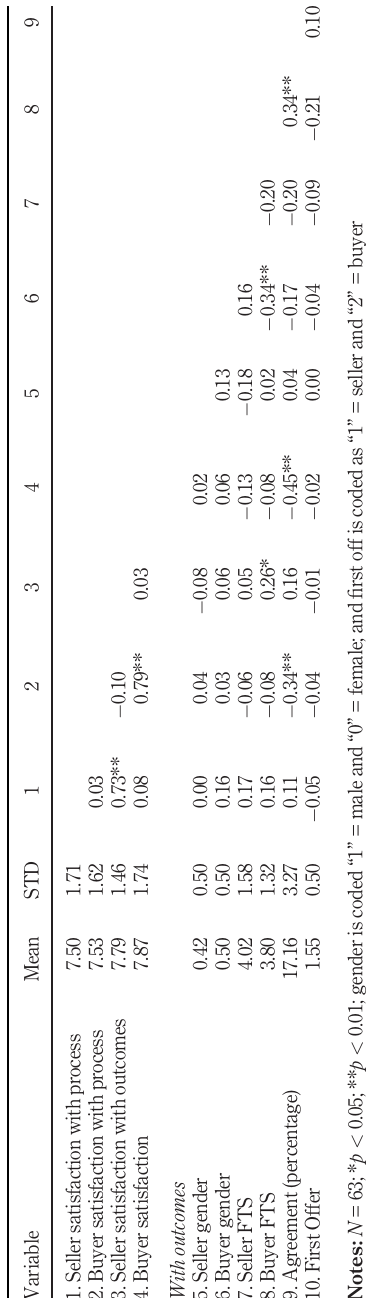
Table 1. Descriptive statistics for study